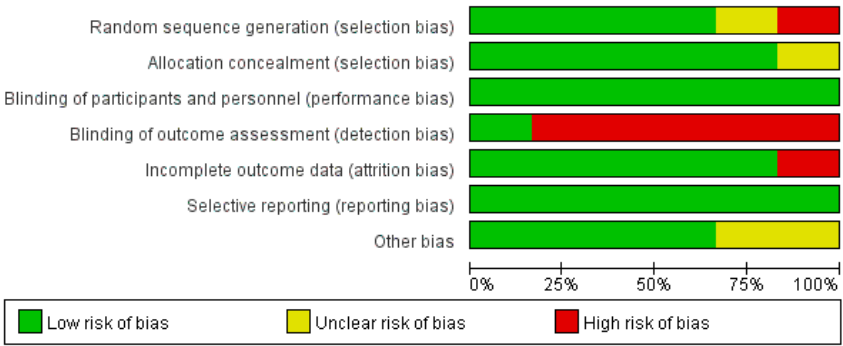
Figure 2. Risk of bias graph.